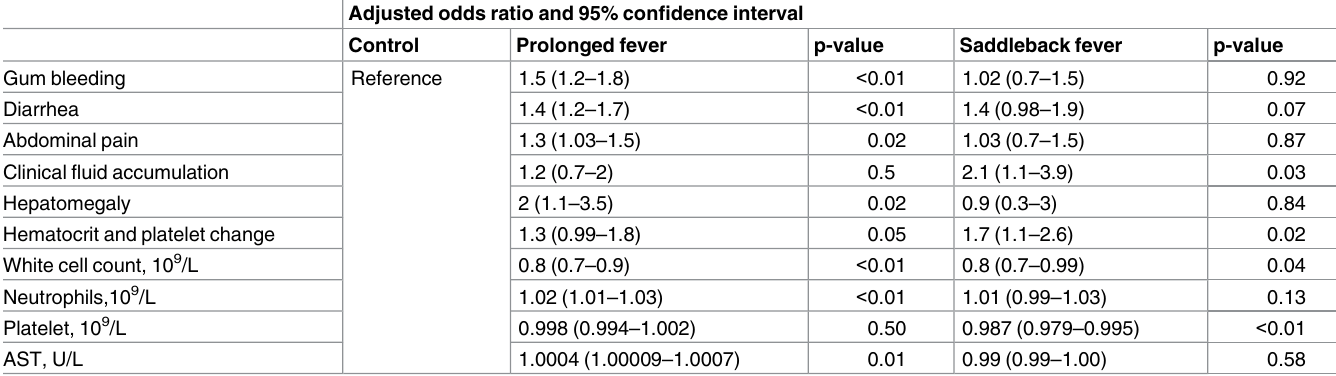
Table 2. Multivariate analysis of associations of prolonged and saddleback fever, adjusted for age and gender.